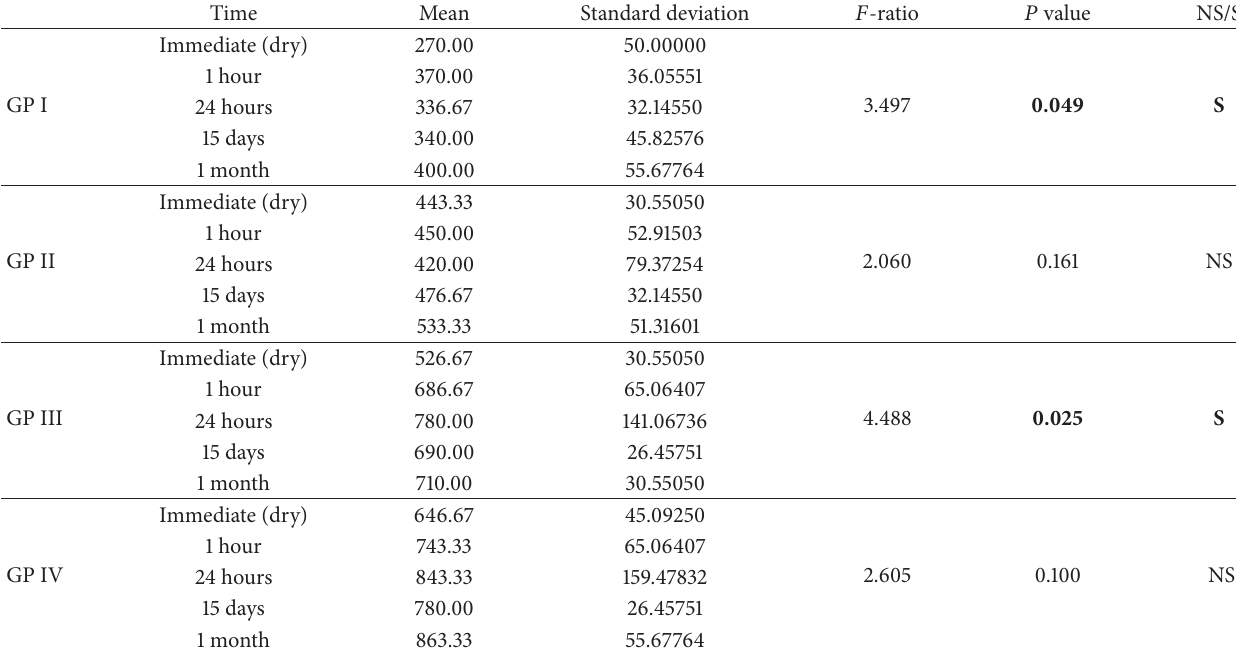
Table 1: Comparison of mean static friction between different groups (ANOVA test).